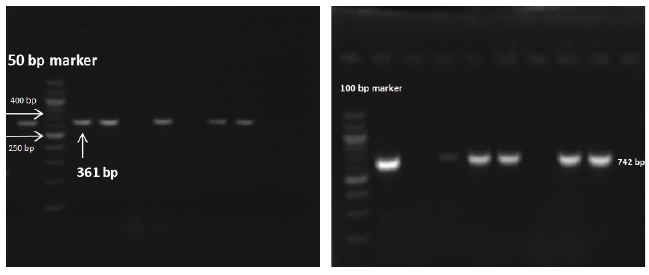
zooepedimicus isolates. However, no emm gene was detected in 8 S. anginosus isolates, either (Table 1). 54 SDSE isolates and 2 S.equi subsp.zooepedimicus, emm gene of which was detected in consequence of emm -PCR, were evaluated for emm typing. When the patient material from